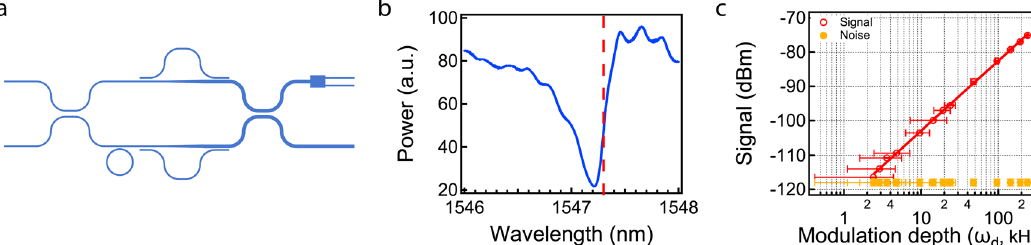
Fig. 4 Frequency measurements. a Schematic of inverse weak value device with ring resonator for frequency shift measurements. b Resonance of the ring resonator. The dashed line indicates the center of laser frequency modulation. c Signal and noise fl oor of the inverse weak value device with changing optical frequency modulation depth. The signal data are fi tted to the lines. The error bars of the modulation depth represent the standard deviation of the applied voltage as reported by the oscilloscope. The error bars of the signal represent the resolution limit of